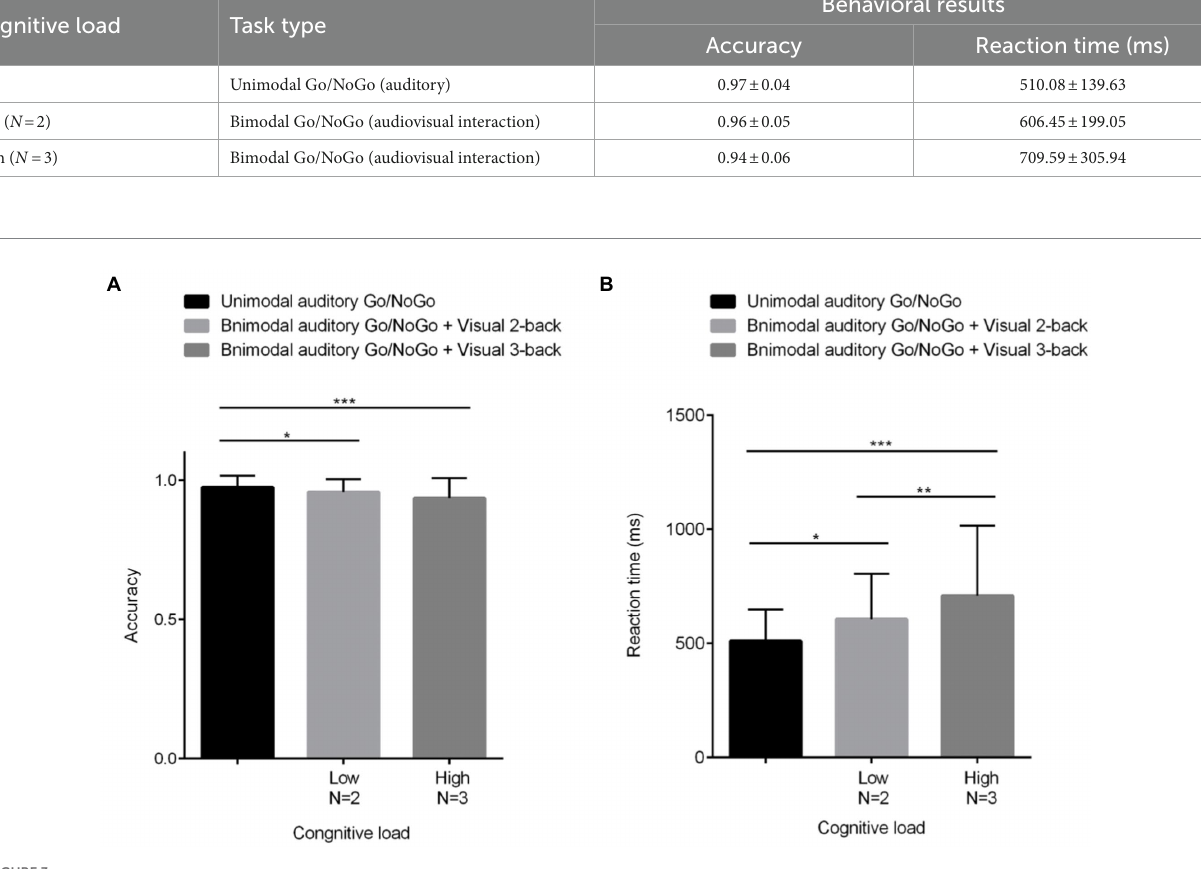
FIGURE 3 Behavioral performance (mean scores and standard deviations) in terms of accuracy (A) and reaction times (B) on the unimodal and bimodal auditory tasks with visual distractors under different visual cognitive loads. Among them, N = 2 represents low cognitive load, and N = 3 represents high cognitive load. As the visual cognitive load increased, the differences in reaction time and accuracy of WM became greater in both the unimodal and bimodal tasks. All the data are presented as the mean ± S.D. ( n = 60); * p < 0.05, ** p < 0.01, *** p < 0.001.